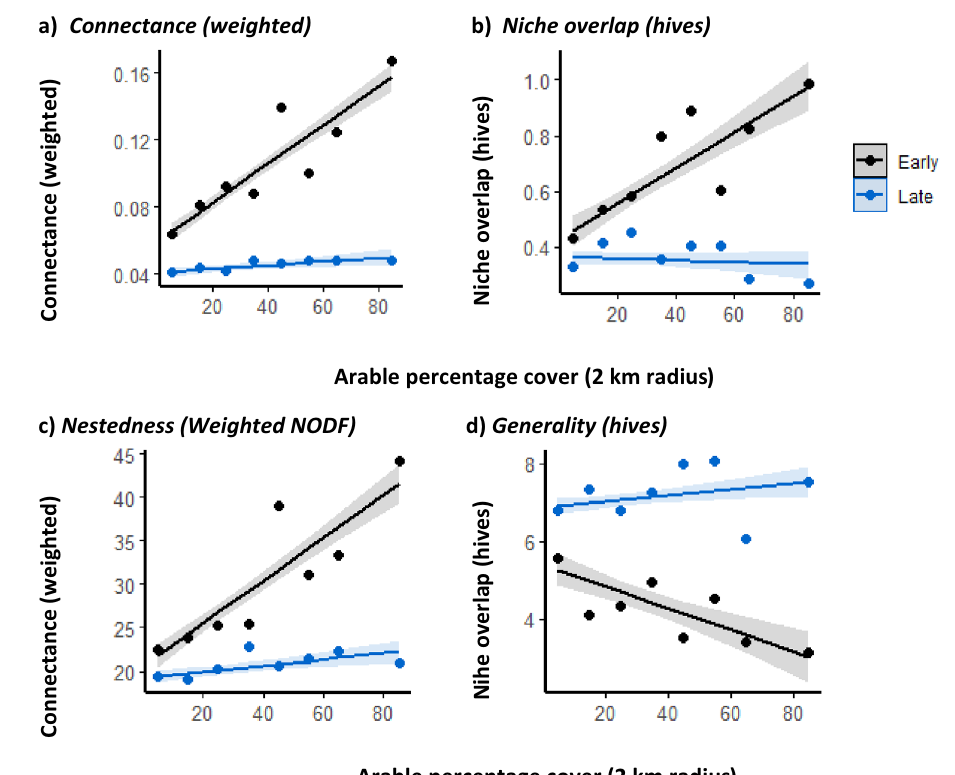
Figure 3. We derived bipartite food webs that describe the foraging associations between individual hives and plants as determined from DNA barcoding of pollen found in honey. These webs were derived depending on the time honey was harvested (early ≤ June or late ≥ July) and the extent to which the landscape was dominated by arable and horticultural land cover. We used these bipartite foraging webs to derive metrics describing the structure of these feeding relationships. These metrics were weighted connectance (realised proportion of possible links between hives and plants), weighted NODF nestedness (the tendency for hives to forage on subsets of plants utilised by better-connected hives, where larger values indicate increased nestedness), niche overlap (mean similarity of interaction patterns for hives with plants) and generality (mean effective number of plants foraged upon per hive). These graphs show how these metrics change in response to the cover of arable and horticultural land in the